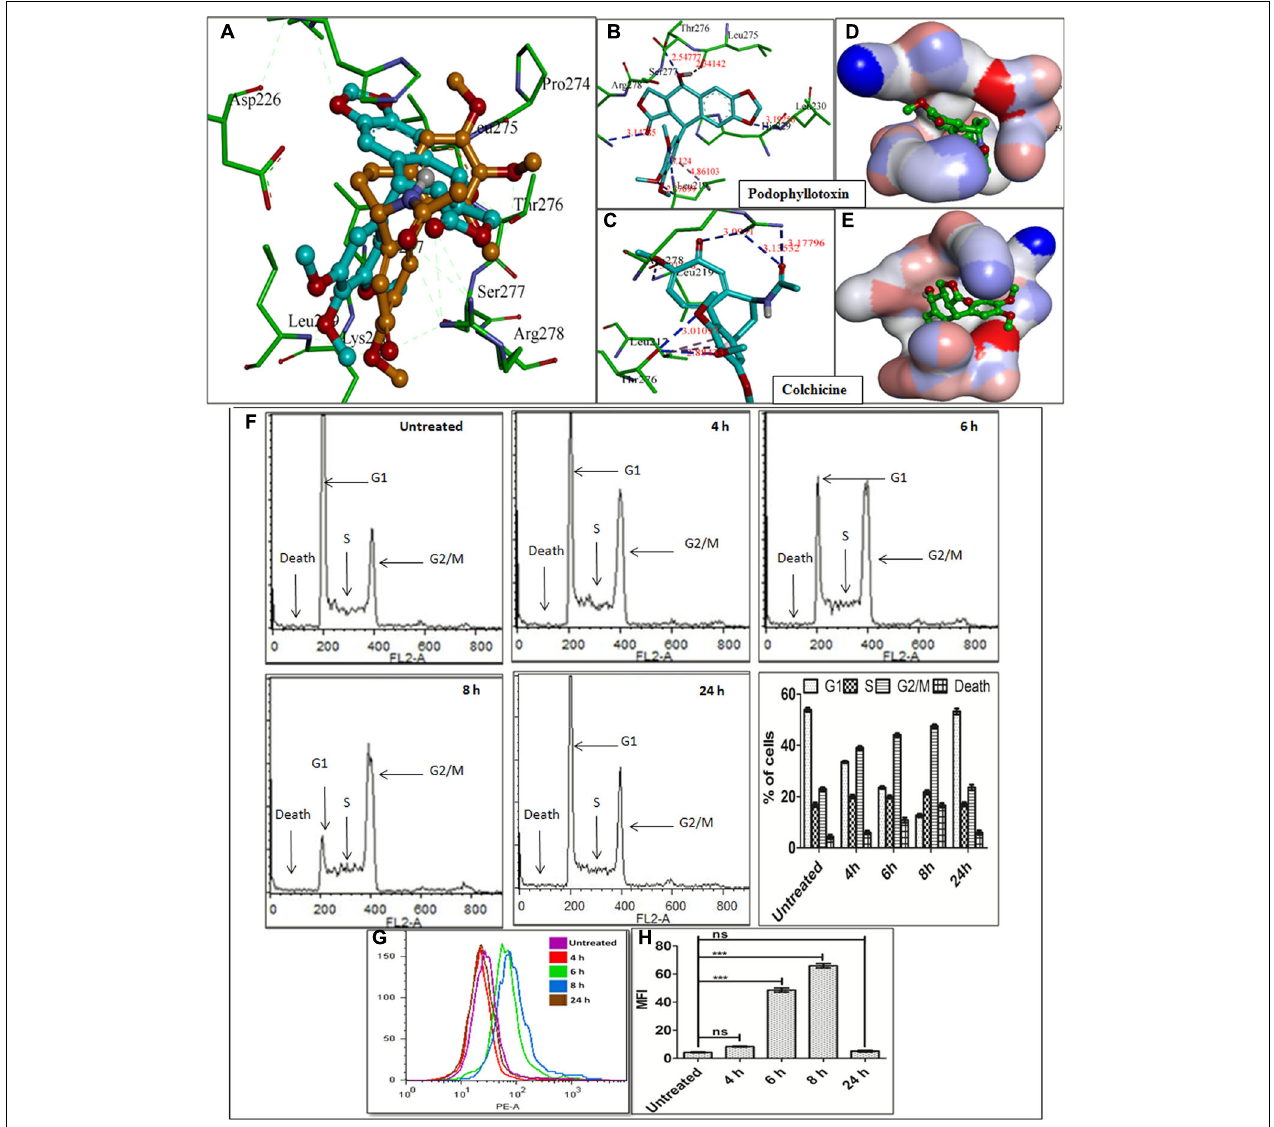
FIGURE 2 | Comparative docking study of podophyllotoxin and colchicine: (A) Docked and superimposed conformations of both, podophyllotoxin (cyan) and colchicine (orange) were represented as Ball and stick model along with the β -tubulin protein residues (green) as stick model. (B,C) Interaction of both podophyllotoxin and colchicin with Binding site residues were represented. (D,E) Charge distribution within the binding pocket was depicted. G2/M arrest by podophyllotoxin in human jurkat cells: Cells were treated with podophyllotoxin for 1 h and cell cycle analysis was performed by propidium iodide method. (F) The histogram represents the different phases of cell-cycle. The bar graph represents percentage of cells in different phages of cell-cycle at 4, 6, 8, and 24 h time points. The bar chart shows the mean ± SD of 6 replicates . (G) The histogram and graph indicate the Cyclin B1 expression study in jurkat cells at different time points. (H) The bars in graph represents mean fluorescent intensity of Cyclin B1 at different time points. n = 6 per